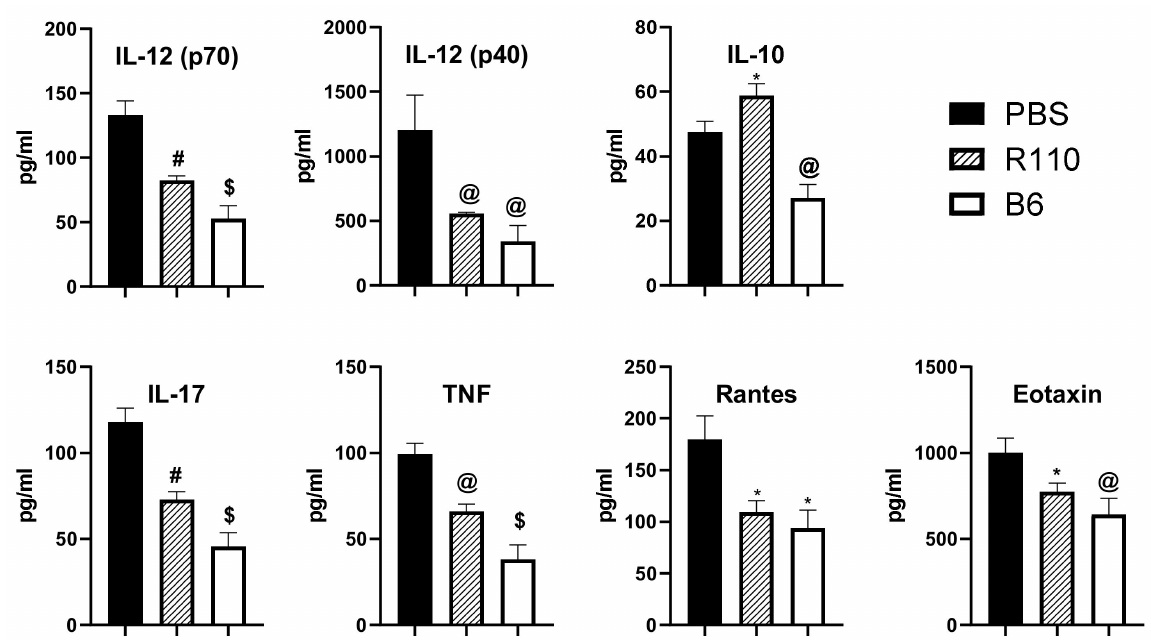
Figure 5. SlpA engages the gut immune cell to reduce systemic inflammation. Serum collected from mice from Rag1 − / − mice after 8 weeks of T cell-mediated colitis initiation. Serum from mice without colitis (B6) was used as reference. Results represent means ± SEMs from three independent experiments; n = 5–10 mice/group; * p < 0.05; @ p < 0.01; # p < 0.001; $ p < 0.0001.